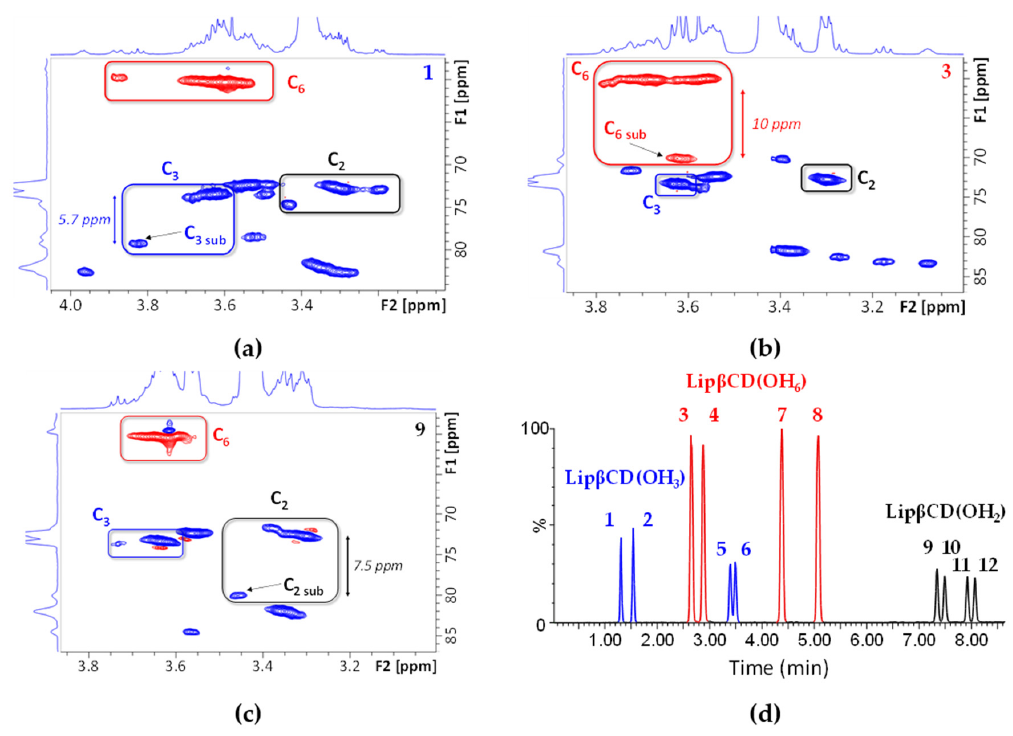
Figure 6. Partial contour plot of 1 H- 13 C HSQC experiments (600 MHz, DMSO/D 2 O 98/2, v / v , 298 K) of isomers 1 ( a ), 3 ( b ) and 9 ( c ). ( d ) EIC of Lip β CD marked with the regioisomers assignment based on HSQC experiments.